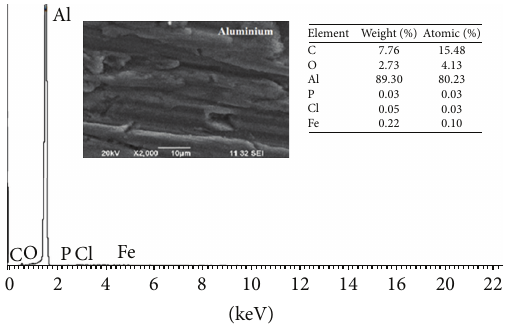
Figure 5: SEM image and EDS spectra of aluminium sample immersed in PBD.